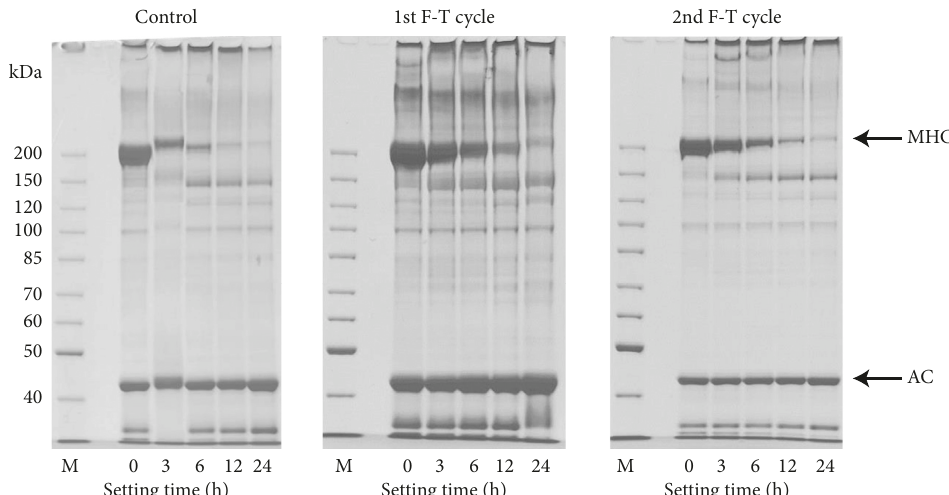
Figure 6: SDS-PAGE pattern of suwari gel prepared from each frozen surimi. M, MHC, and AC indicate the protein marker, myosin heavy chain, and actin, respectively.